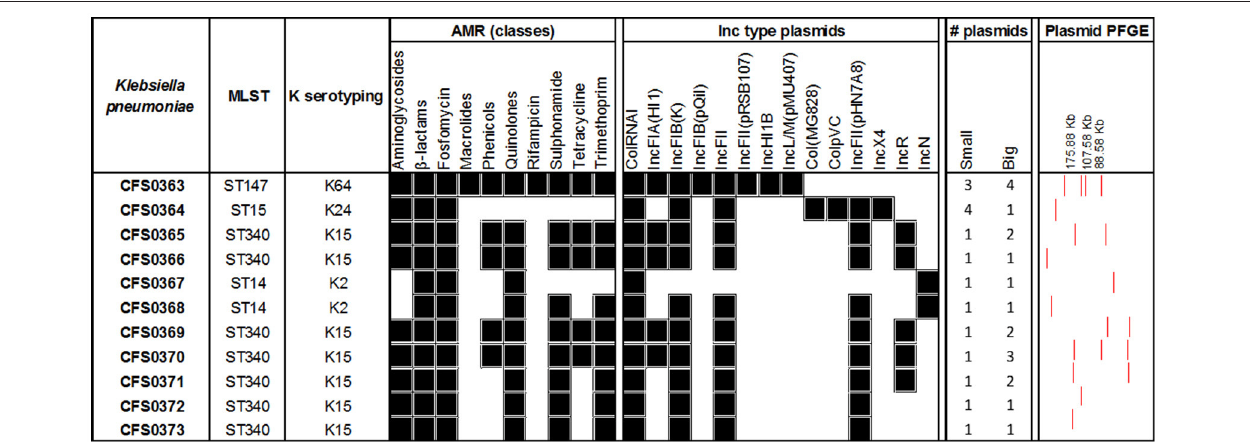
FIGURE 4 | Genomic analysis of Klebsiella pneumoniae clinical isolates. Antimicrobial resistance genes were grouped by class and the presence of at least one gene was considered as a positive result (black). The number of plasmids was identified from the gels (large plasmids > 25 kb, small plasmids 2–25